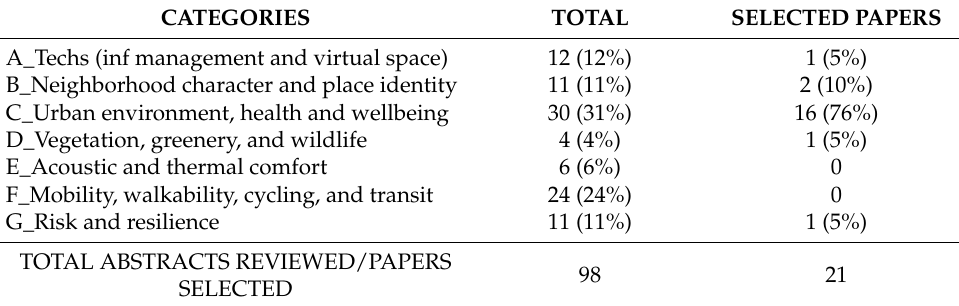
Table 3. Urban planning study fields of the review and selected